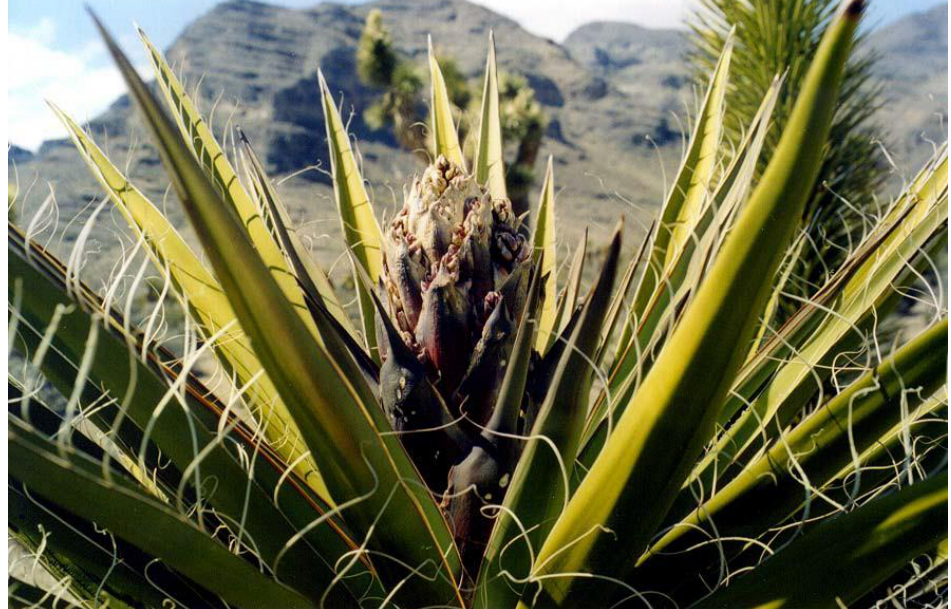
Figure 22. Yucca Tree (Yucca schidigera ) flower and fruit (Source: Stoffle).